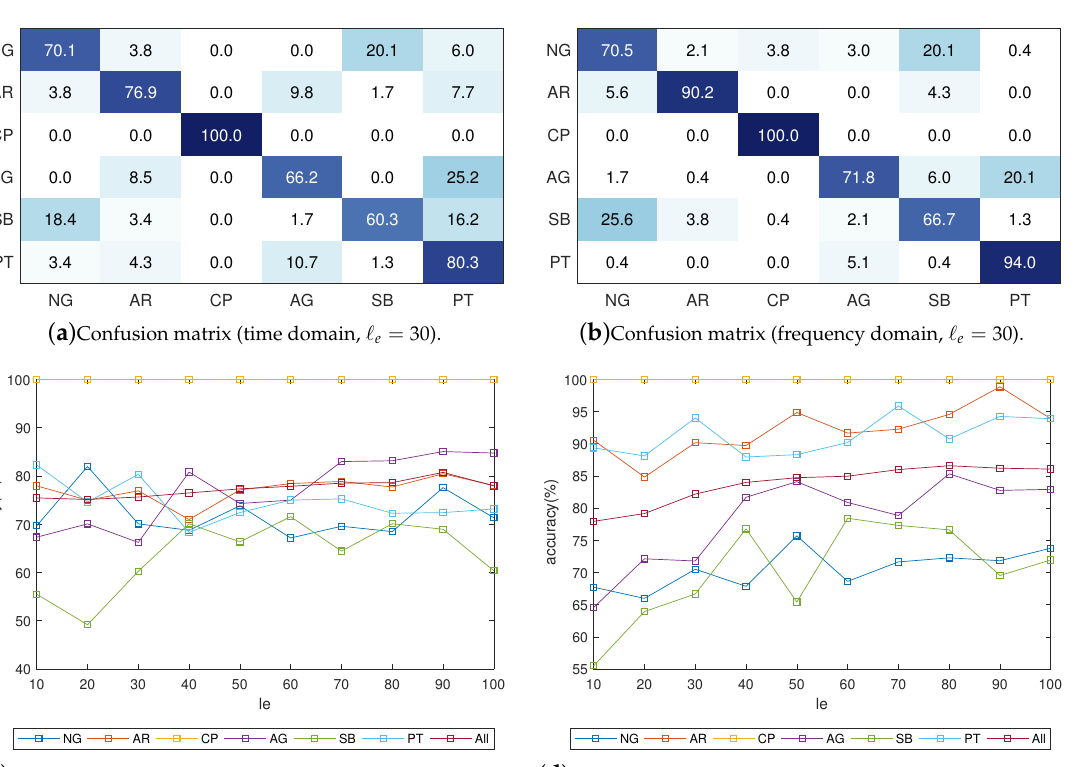
( d ) Variations of classification accuracies over (cid:96) e (frequency domain). Figure 7. Classification performance of SVM under Labelling Strategy 1